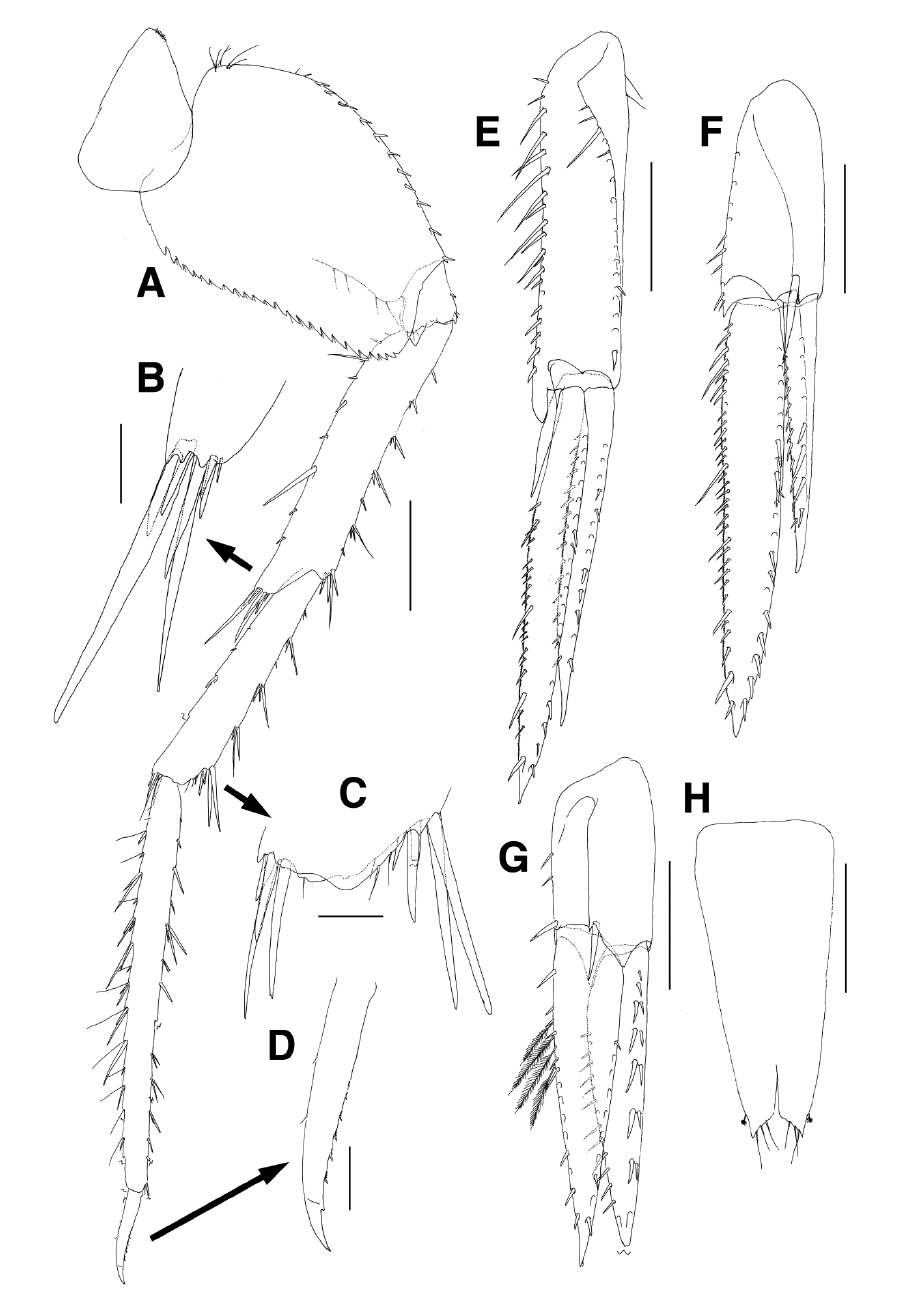
Figure 6. Eusirus bulbodigitus sp. n., holotype, male, NIBRIV0000332003, 11.3 mm. Jeju Island, South Korea. A Pereopod 7 B Posterodistal setae of merus on pereopod 7 C Distal part of carpus on pereopod 7 D Dactylus of pereopod 7 E Uropod 1 F Uropod 2 G Uropod 3 H Telson. Scale bars=0.1 mm ( B–D ), 0.4 mm ( E–H ), 0.5 mm ( A